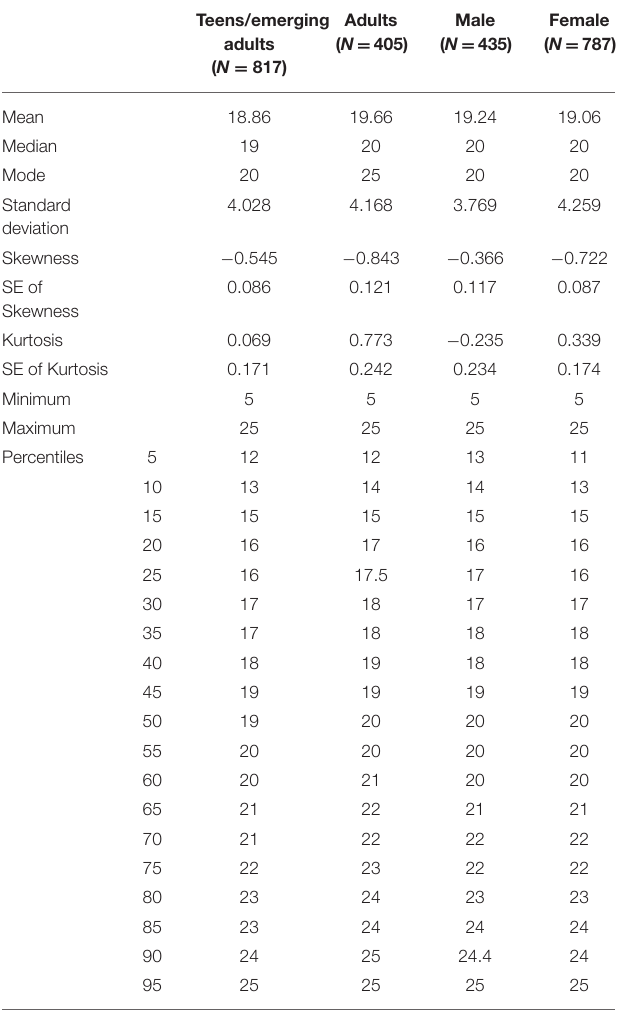
TABLE 4 | Descriptive statistics and percentiles for the satisfaction with life scale (SWLS) by age group and by gender. Teens/emerging